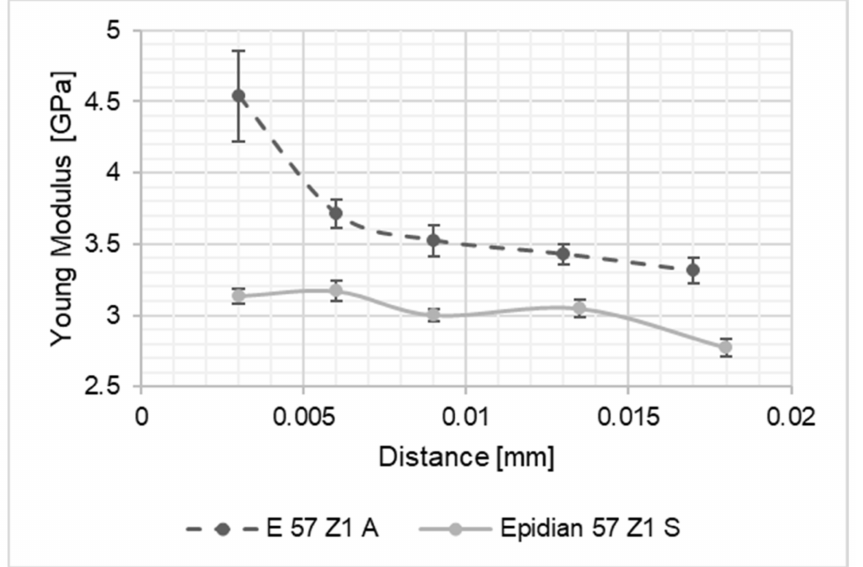
Figure 7. Comparison of Young’s modulus values for the Epidian 57/Z1 joint bonding: A— aluminium alloy sheets; S—stainless steel sheets, as